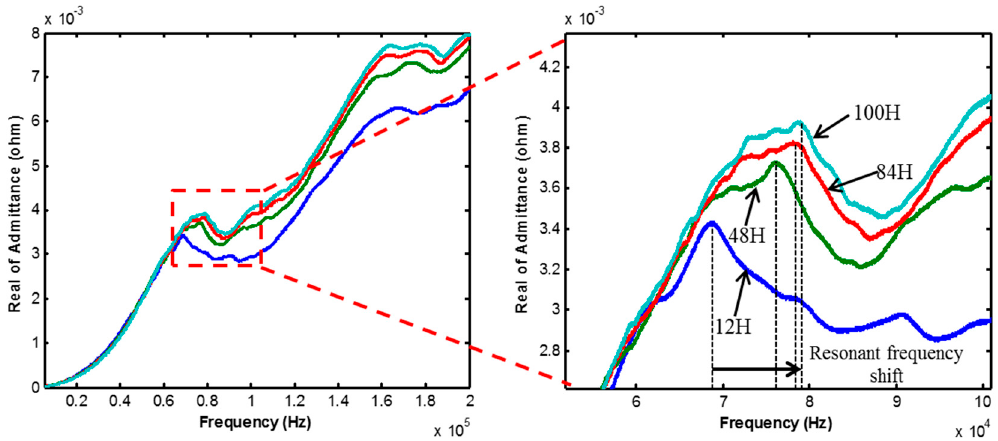
Figure 7. EMI variation of module 2.